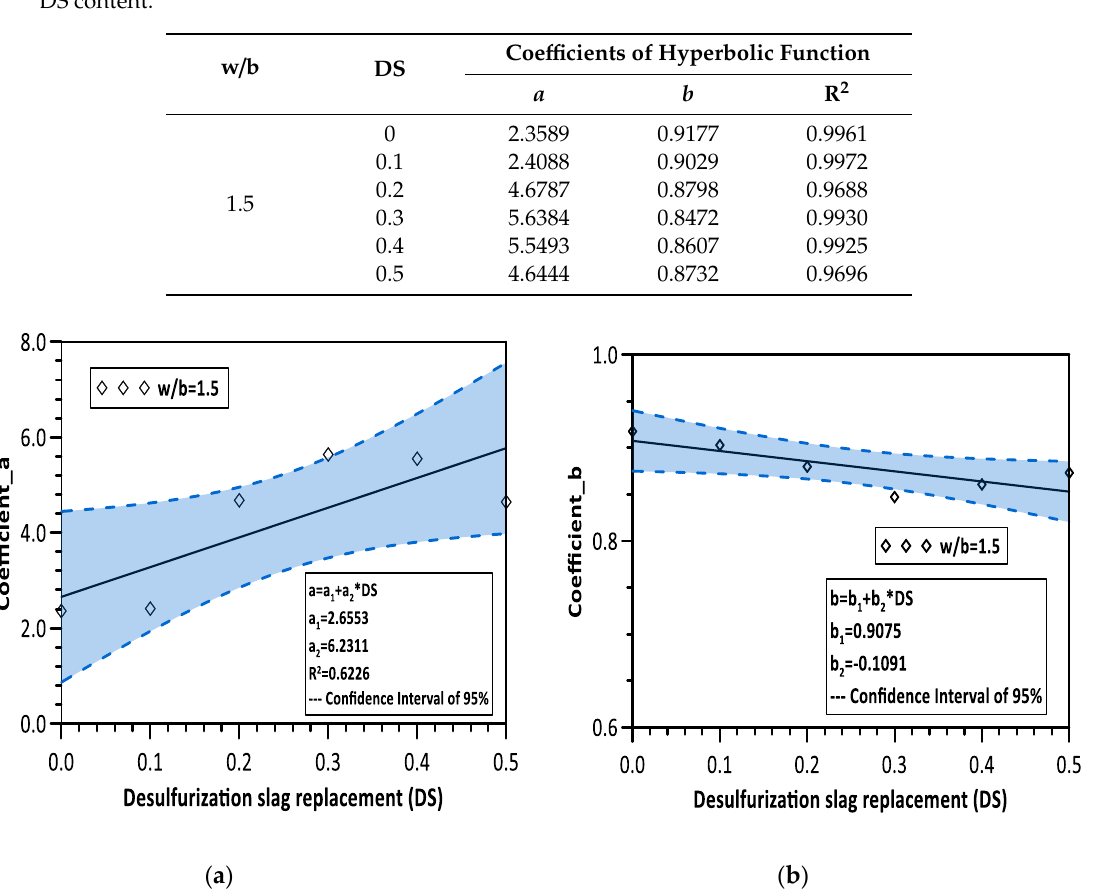
Table 4. Hyperbolic function coe ffi cients of the compressive strength prediction analysis based on the DS content.